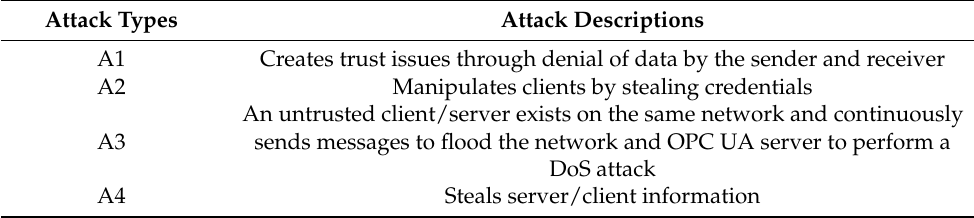
Table 15. Attack types and descriptions based on the attack